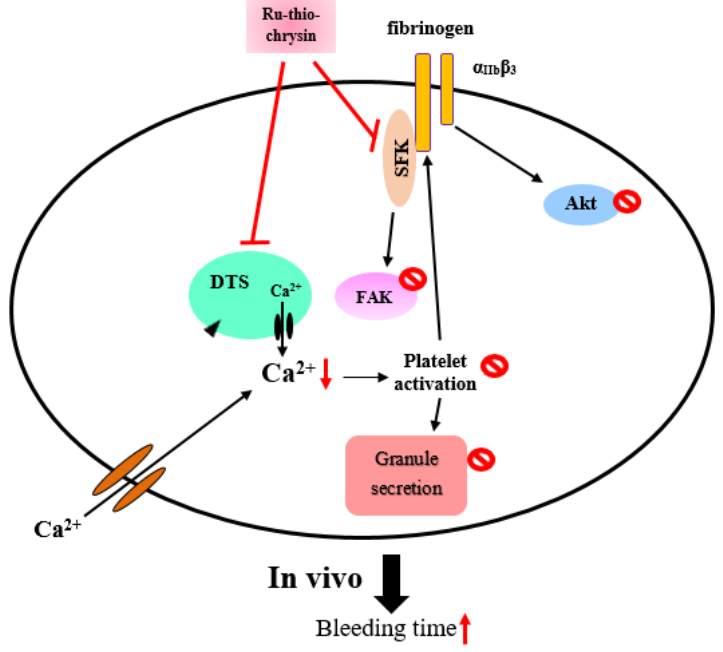
Figure 3. Molecular targets of Ru-thio-chrysin to its inhibitory effects on platelet function.